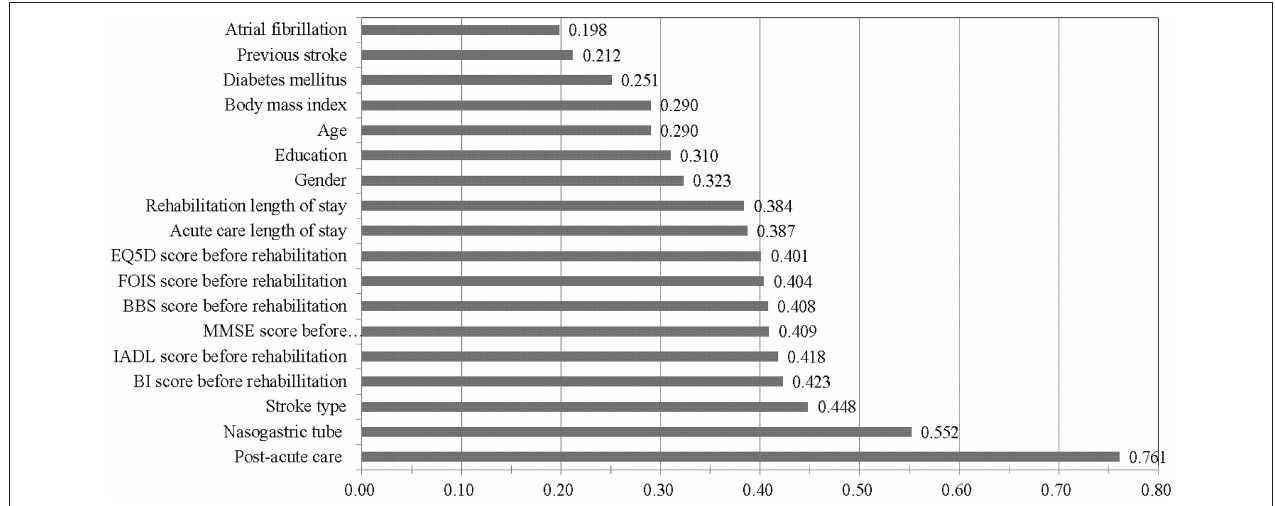
FIGURE 4 | A permutation importance analysis of artificial neural network model in predicting 30-day readmission in patients with stroke. BI, Barthel Index; IADL, Instrumental Activities of Daily Living; MMSE, Mini-Mental State Examination; BBS, Berg Balance Scale; FOIS, Functional Oral Intake Scale; EQ-5D, EuroQoL Quality of Life Scale.